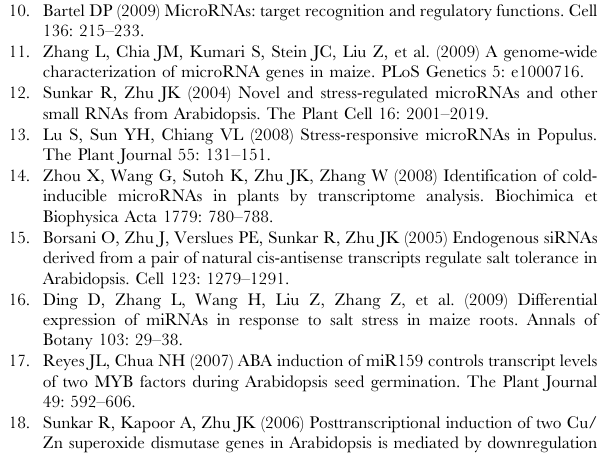
the Hz32 control library. The third column is the RPM of Hz32 at 4 h treatment library. The last column is the relative change. Chi- square test is applied to the relative change and * denotes the p value , 0.01. Table S4 Novel mature miRNA and their precursor with genome coordinates. The table gives the information of the predicted novel miRNA such as genome coordinate, mature sequence and pre-miRNA sequence. Table S5 Targets of novel miRNAs with interpro annotation. List of novel miRNA targets with interpro id and description. MM: miss match. Table S6 miRNA SLRT-PCR primers and their target function. The first column is the miRNA id. The second column is the gene specific forward primer for the SLRT-PCR. The third column is the stem loop primer for the first strand cDNA amplification. The last column is the predicted miRNA targets annotation. Universal reverse primer is for the SLRT-PCR reaction. Table S7 qRT-PCR internal control primers. Maize 18s ribosome RNA gene was used as the internal control to normalize the qRT-PCR results. Table S8 miRNA targets qRT-PCR primers. The first column is the miRNA id. The second column is the target gene id. The third column is the gene specific forward primer for the qRT- PCR. The fourth column is the gene specific reverse primer for the qRT-PCR. The fifth column is the designed product size (around 200 bp). The last column is the targets annotation. Table S9 5’RLM-RACE validation of the miRNA targets nested PCR primers. The first column is the miRNA id. The second column is the target gene id. The third column is the gene specific outer primer for the PCR. The fourth column is the gene specific inner primer for the PCR. The fifth column is the designed product size. The last column is the targets annotation. 5 9 RLM- RACE adapter is the adapter used for the 5 9 RACE analysis.